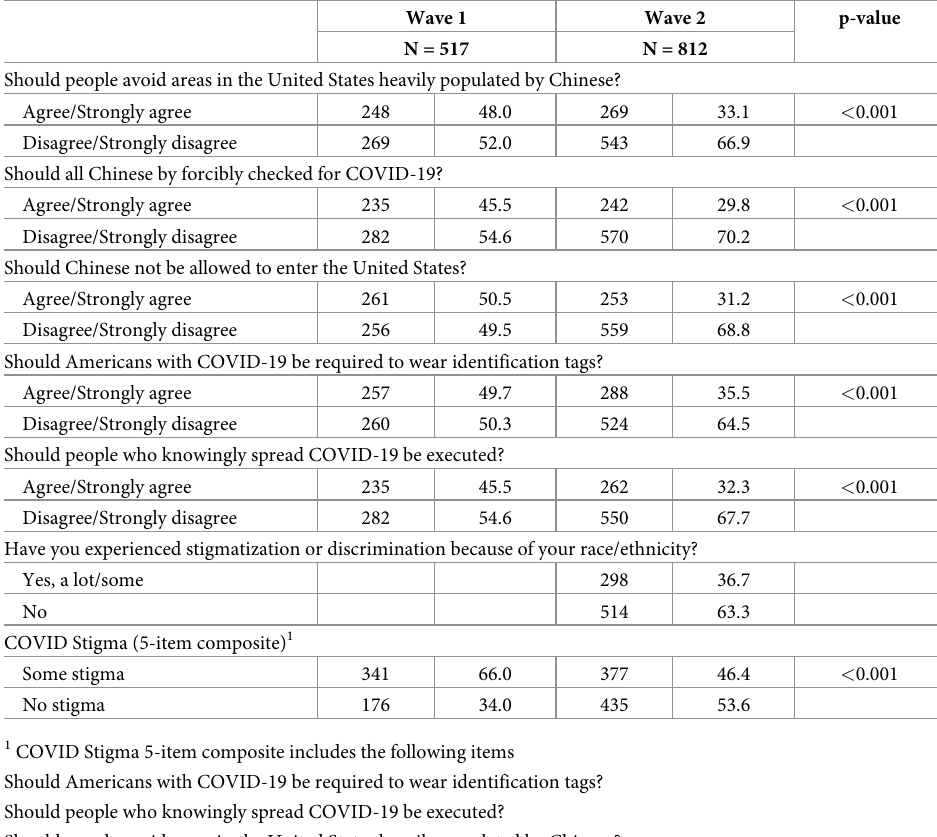
Table 3. Endorsements of the five SABR items for Waves 1 (N = 517) and 2 (N =